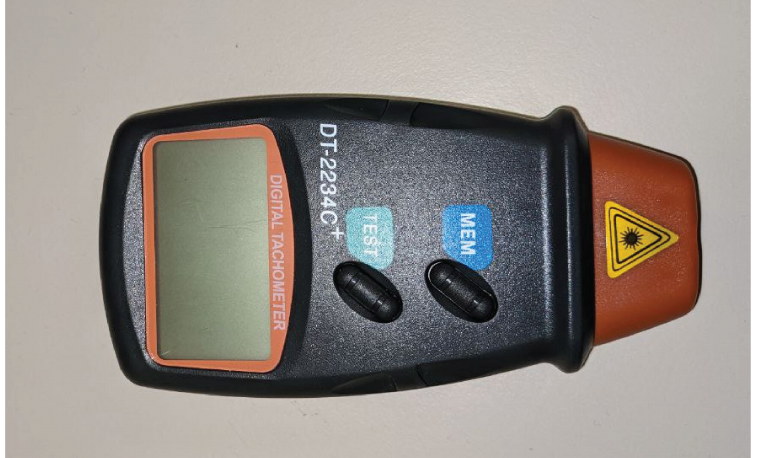
Figure 12. The digital laser tachometer DT2234C+ used in this